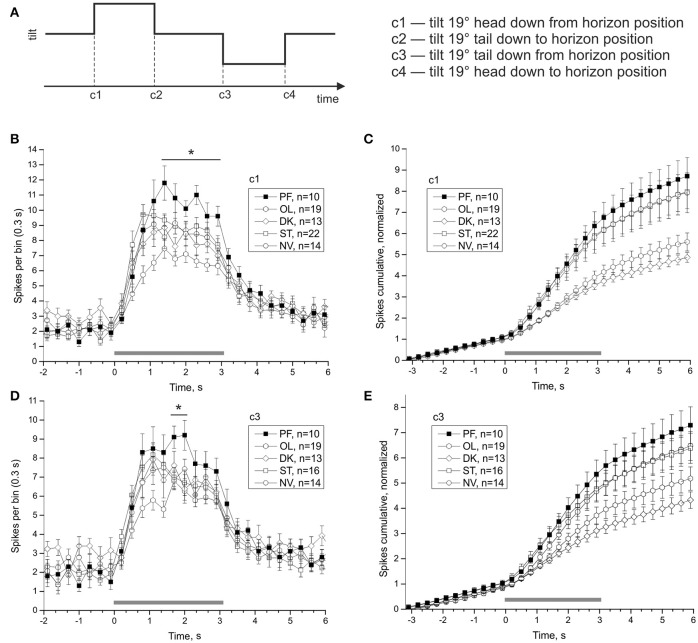
Averaged statocysts responses to vestibular stimuli. (A) Sequence of presented tilts. Upward displacement of the platform corresponds to head-down tilt of the animal tilt. (B,D), Peri-stimulus curves of averaged responses to stimuli in two opposite directions. (C,E), Cumulative curves of responses for the same stimuli, normalized to background firing rate. *p < 0.05.